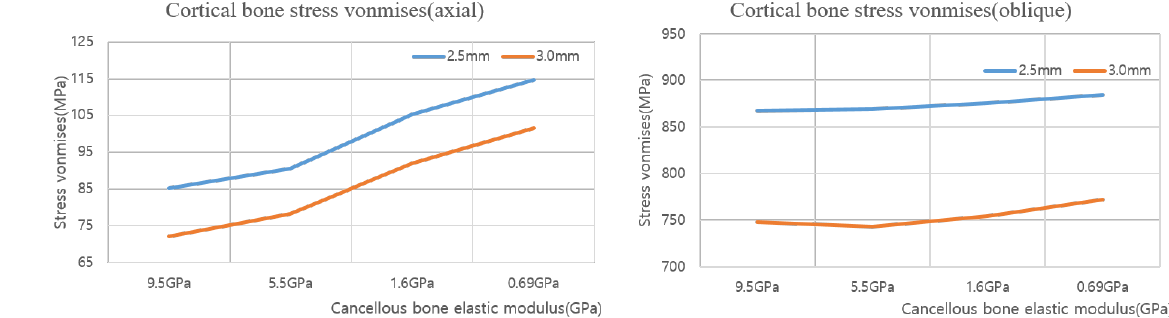
Figure 15. Cortical bone von Mises stress value charts.